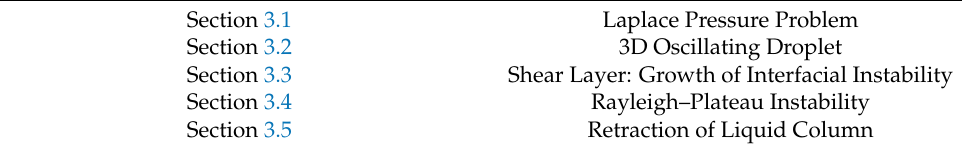
Table 1. Evaluation exercises considered in the present